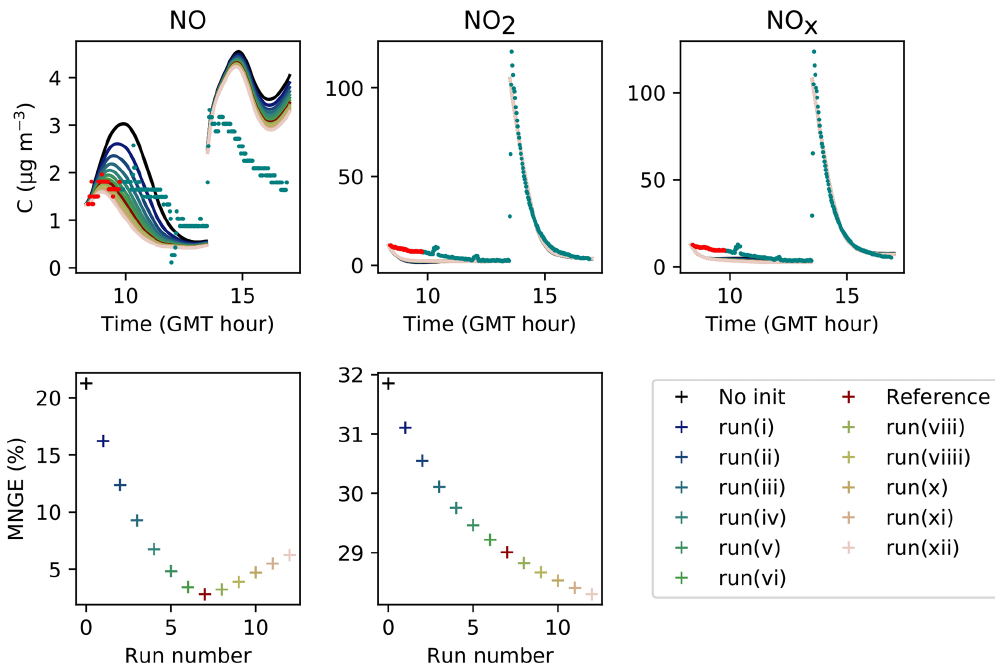
Figure B1. Concentration initialization for Experiment 1: for this experiment, proper initial concentrations are considered to be achieved when the MNGE with respect to NO reaches a minimum. The MNGE of NO 2 remains high because the parameter optimization regarding NO 2 focused on the correct modelling of the second part of the experiment (see Sect. 6, modelling high NO 2 concentrations).